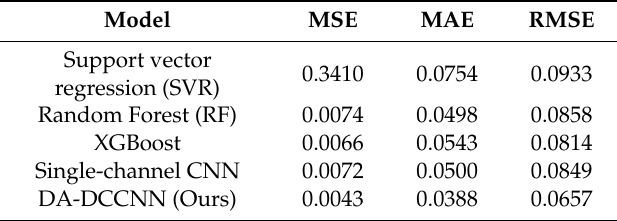
Table 7. Comparison of errors among different models.